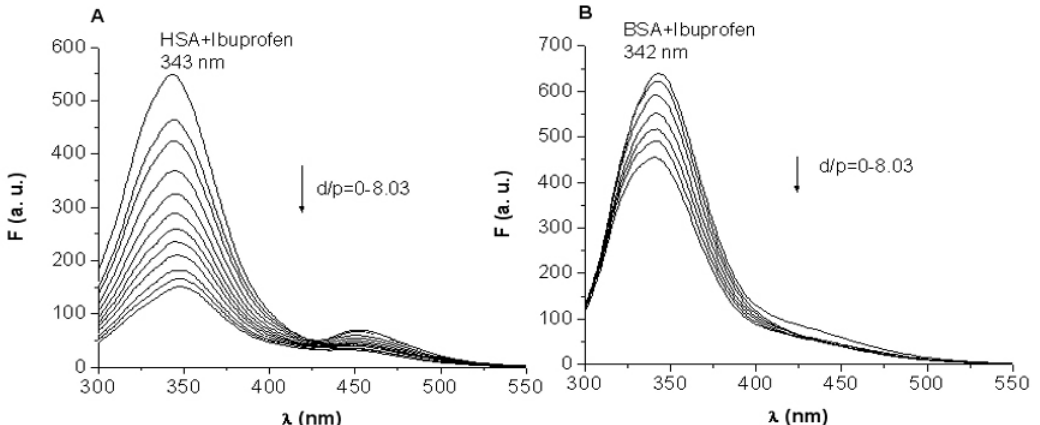
Figure 8. Effect of site marker ibuprofen to A) (I)-HSA system, [ibuprofen]=[HSA] =0.75×10 -6 M; B) (I)-BSA system, [ibuprofen]=[BSA] =0.75×10 -6 M, T = 298 K, λ = 286 nm, d/p=0-8.03. ex